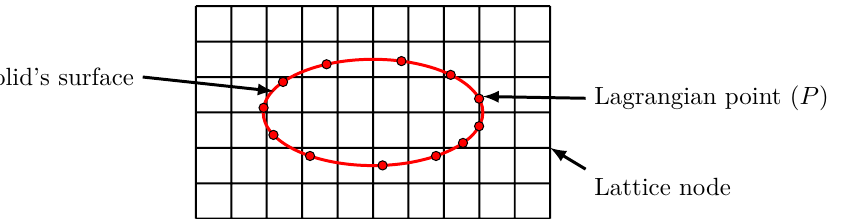
Figure 5. Solid surface represented with Lagrangian points on a